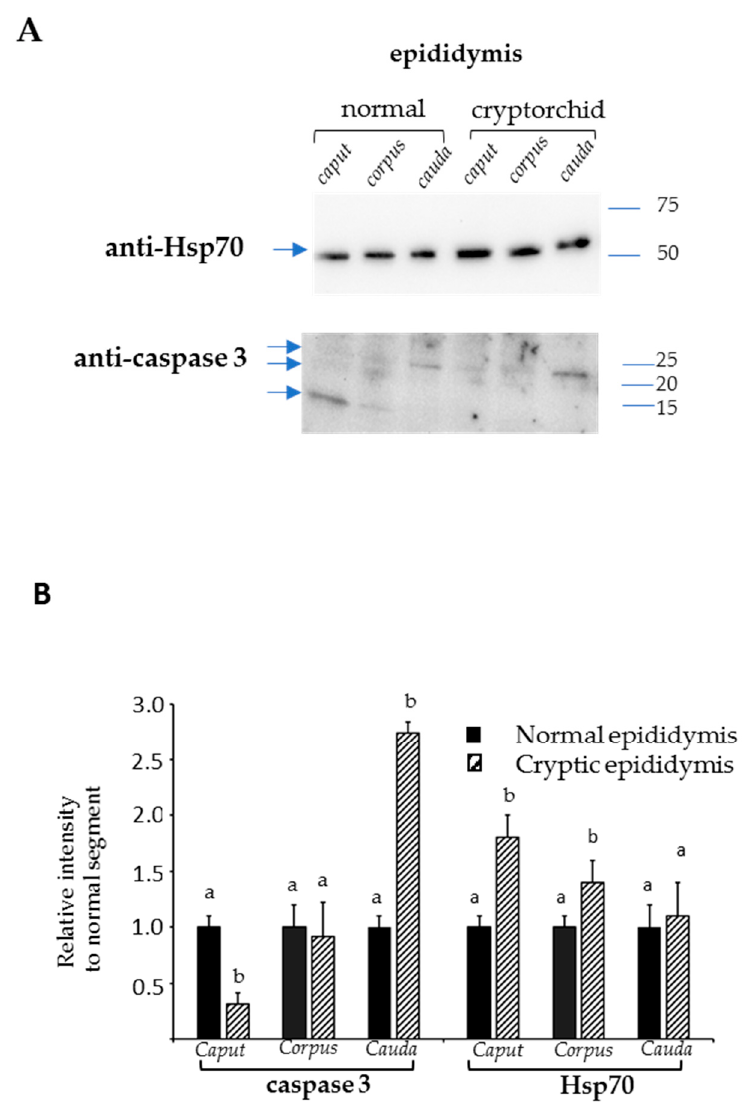
Figure 6. Western blot analysis of Hsp70 and caspase-3 in the epididymal tracts of normal and cryptorchid dogs ( A ). Densitometric analysis of the expression levels of Hsp70 and caspase-3 ( B ). Different letters depict differences between the examined groups ( p < 0.05).